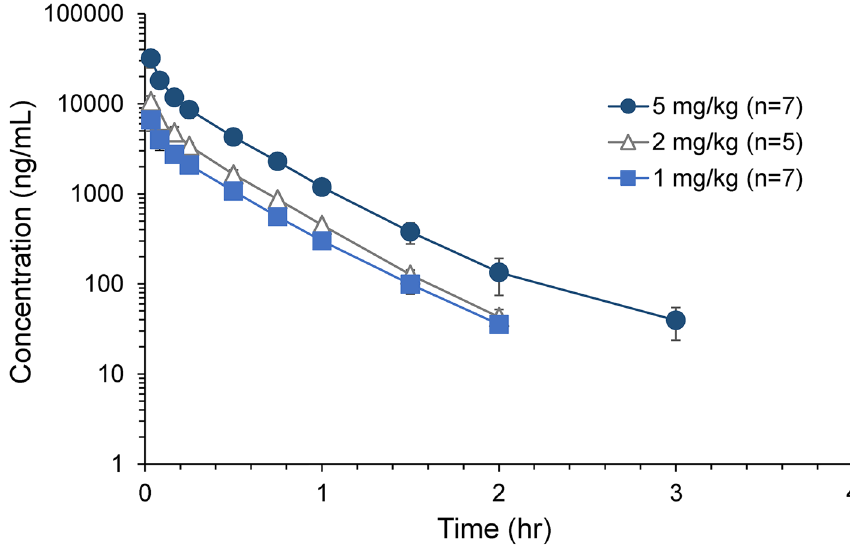
Figure 3. Average plasma concentration of 175 Lu-DOTA-PSMA-GUL vs. time profiles obtained after intravenous injection of 1, 2, and 5 mg/kg 175 Lu-DOTA-PSMA-GUL in rats (n = 5–7).